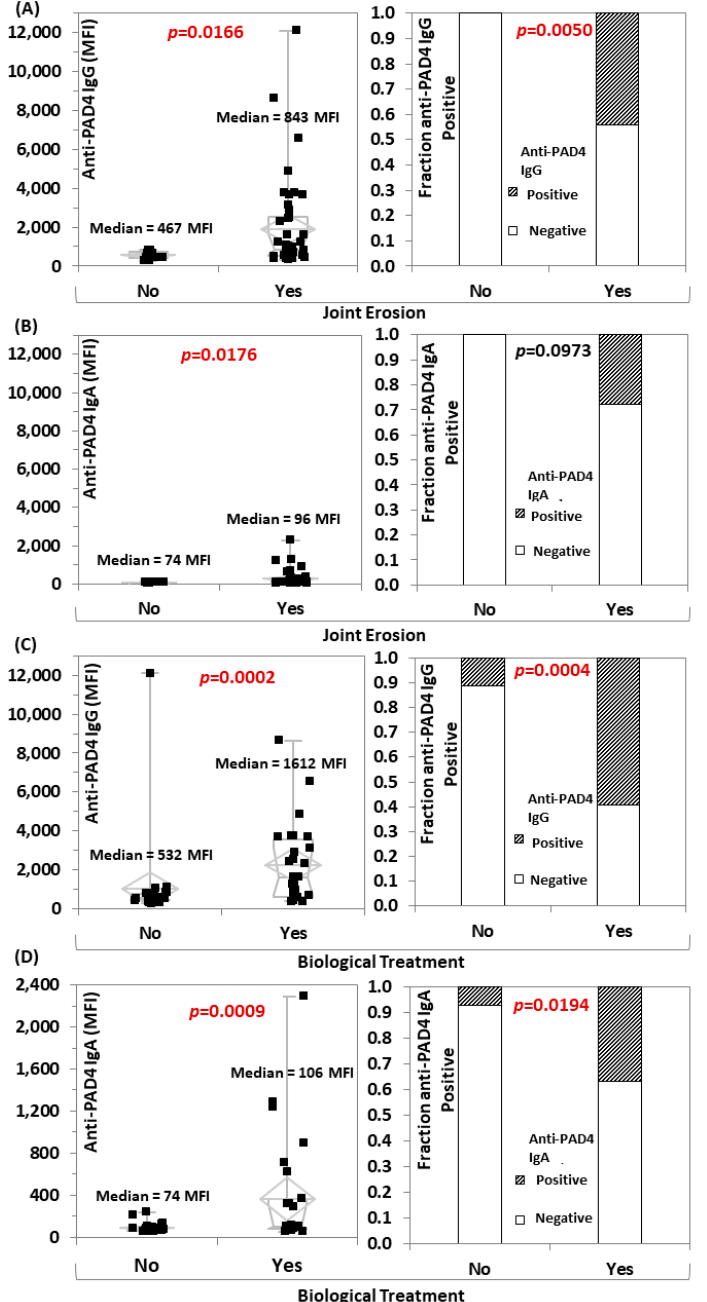
The anti-PAD4 IgG and IgA levels were significantly higher in RA patients vs. con- trols ( p = 0.0004 and p < 0.0001, respectively) (Figure 2A,B). Interestingly, higher levels of anti-PAD4 IgG and IgA, but not ACPA, were found in the RA patients with erosive dis- ease vs. individuals without erosions ( p = 0.0166, p = 0.0176, and p = 0.7883, respectively) biologics ( p = 0.0002, p = 0.0009, and p = 0.7752, respectively) (Figure 2C,D).